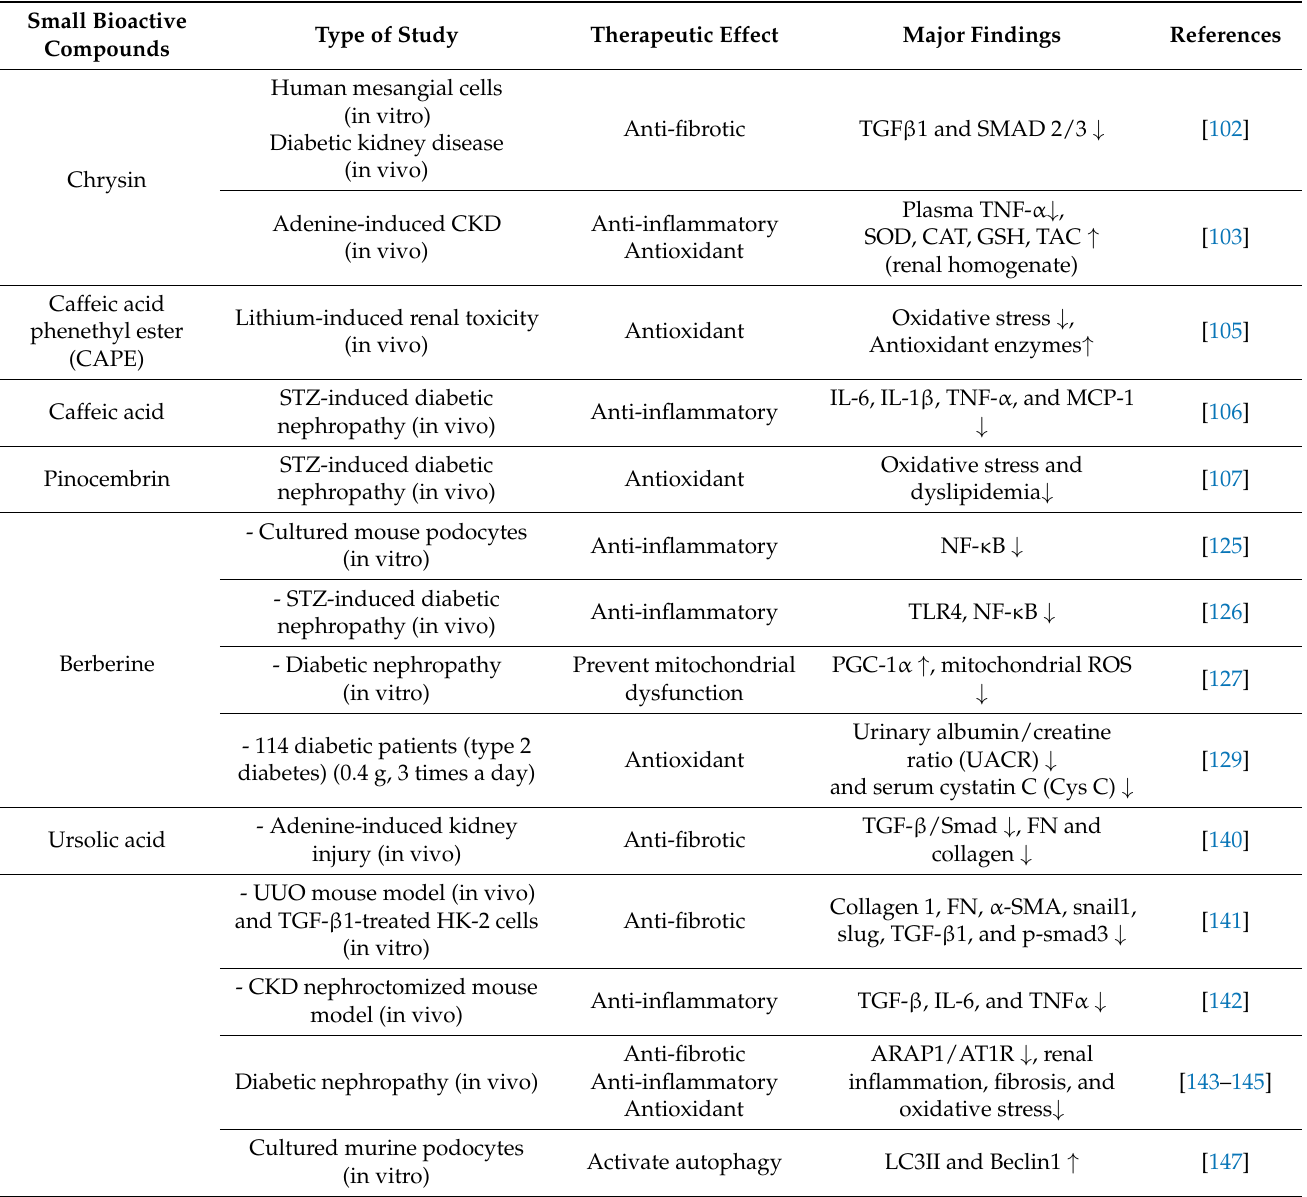
Table 2. Overview of studies investigating the protective effect and the possible mechanistic pathways of small bioactive compounds against CKD. Decreased ( ↓ ) or increased ( ↑